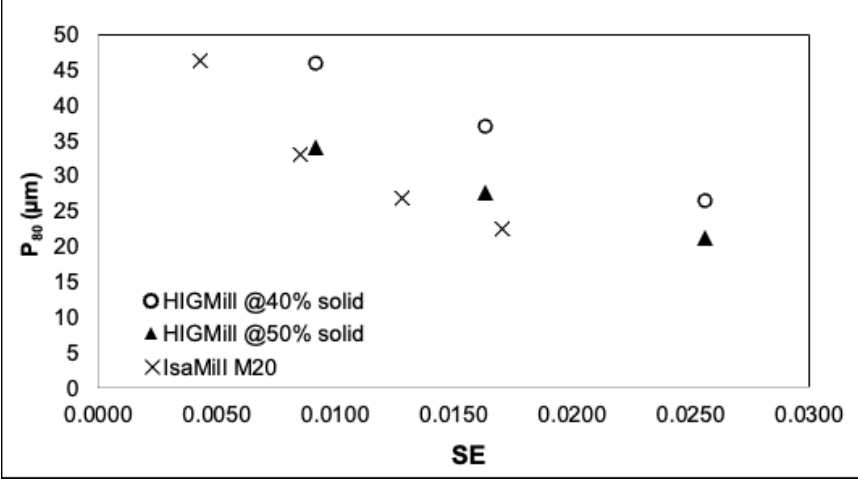
Figure 13. Stress energy comparison of IsaMill and HIGMill.